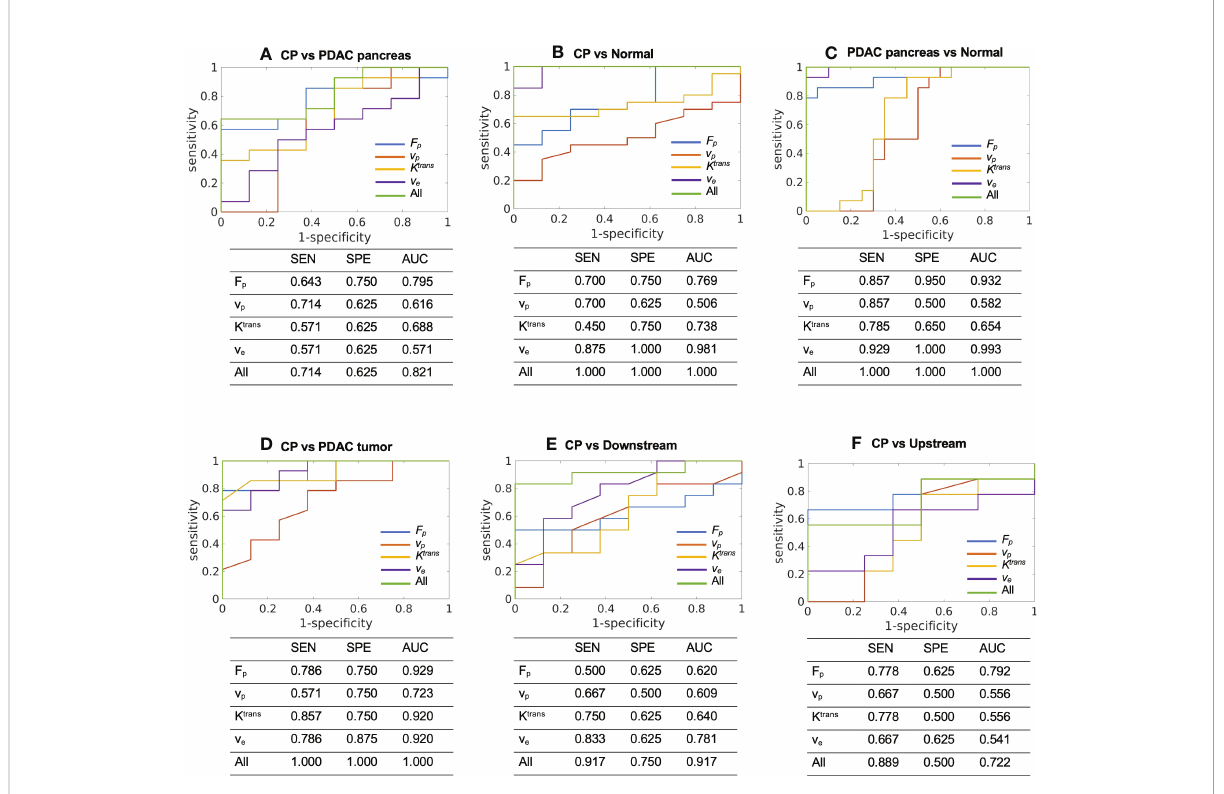
FIGURE 4 ROC curves and the sensitivity (SEN), speci fi city (SPE), and AUC to differentiate between (A) CP (N = 8) versus PDAC pancreas (N = 14), (B) CP (N = 8) versus normal control pancreas (N = 20), (C) PDAC pancreas (N = 14) versus normal control pancreas (N = 20), (D) CP (N = 8) versus PDAC tumor (N = 14), (E) CP (N = 8) versus PDAC downstream (N = 10), and (F) CP (N = 8) versus PDAC upstream (N = 9) using each single microcirculation parameter or the combination of all the four parameters. SEN, sensitivity; SPE, speci fi city; AUC, area under ROC